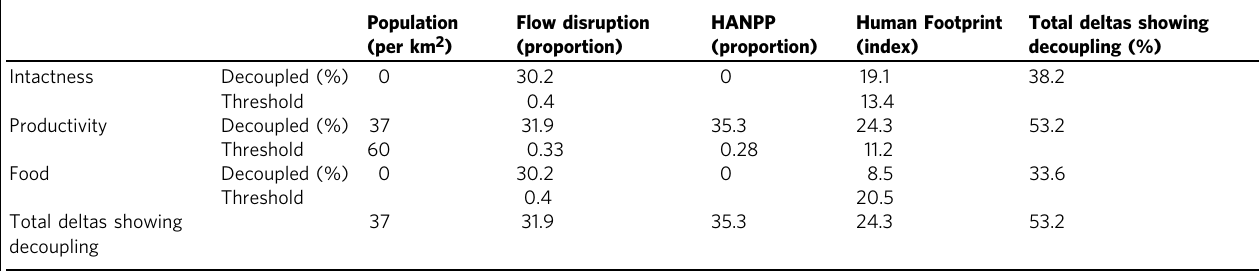
See Table 3 for the composition of each bundle. The rightmost column indicates the percentage of deltas showing decoupling for that ecosystem service bundle for one or more modi fi cation indicators. The bottom row indicates the percentage of deltas showing decoupling for that modi fi cation indicator for one or more ecosystem service bundles. The bottom right number (53.2%) indicates the total percentage of deltas that show decoupling at least once. All thresholds marked indicate a response curve with a pseudo -r >0.1 (see Fig.